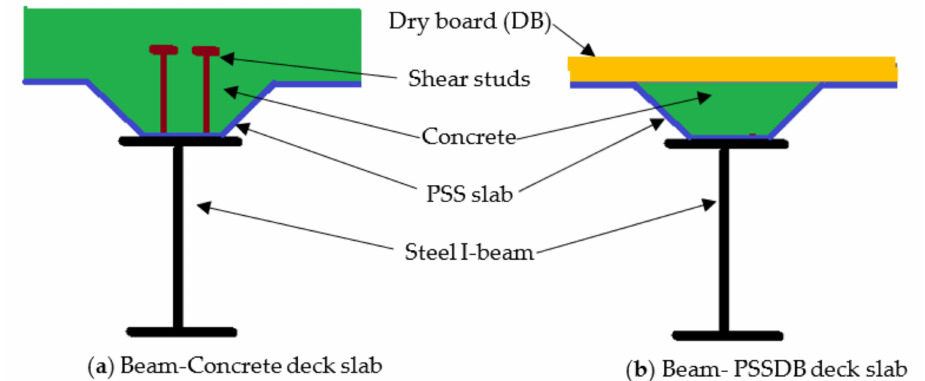
Figure 1. Composite steel beam–slab